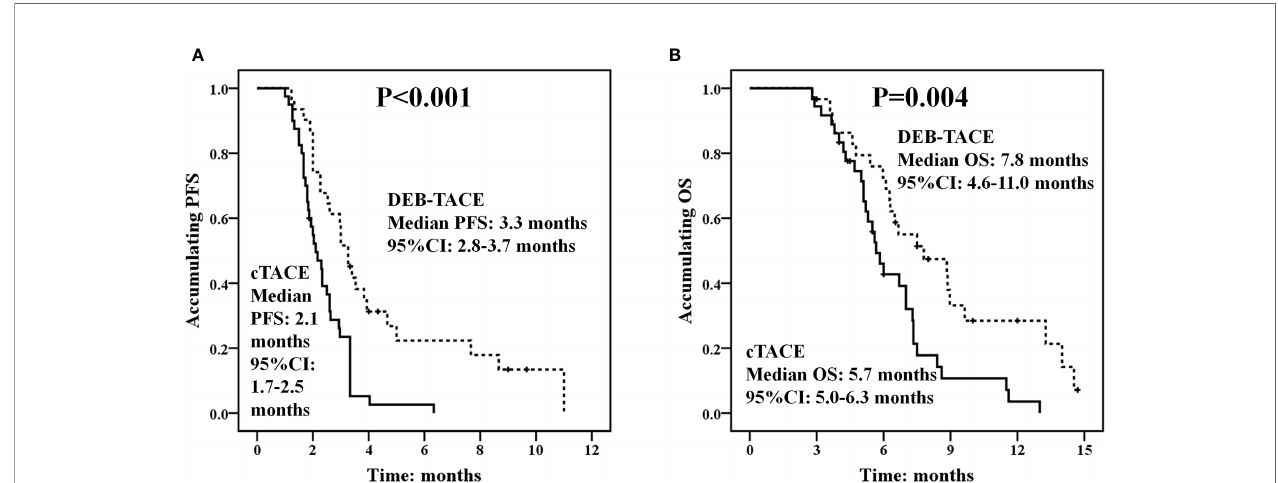
FIGURE 4 | PFS and OS between the DEB-TACE and cTACE groups. PFS was better in the DEB-TACE group compared with the cTACE group (A) , and longer OS was observed in the DEB-TACE group compared with the cTACE group as well (B) . Kaplan-Meier method was used to assess PFS and OS of huge HCC patients and difference between the two groups was determined by log-rank test. p < 0.05 was considered signi fi cant. DEB-TACE, drug-eluting bead transarterial chemoembolization; cTACE, conventional transarterial chemoembolization; PFS, progression-free survival; OS, overall survival.